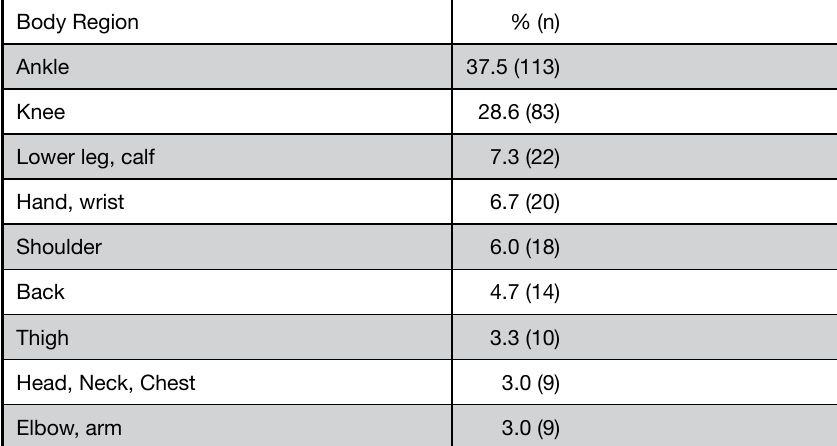
Table 2: General injury rate (n=301) Body Region